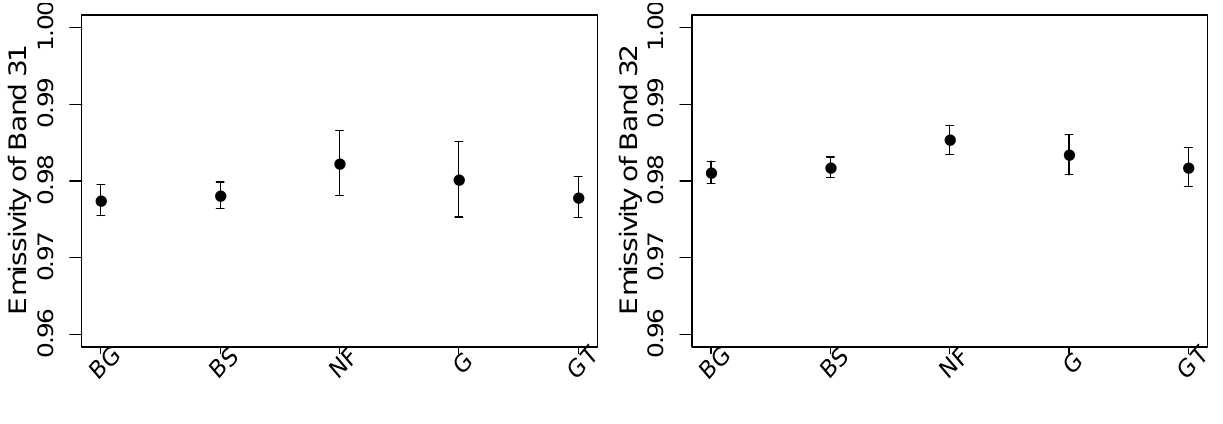
Figure 4. The mean (dots) and ± 1 σ (bars with caps) from the mean emissivities over the period of 14 days (May 10–23, 2011) in bands 31 & 32 of MODIS over 5 LC types (BG: Barren-Gravel, BS: Bush-Scrub, NF: Native Forest, G: Grassland, GT: Grassland-Tussock).